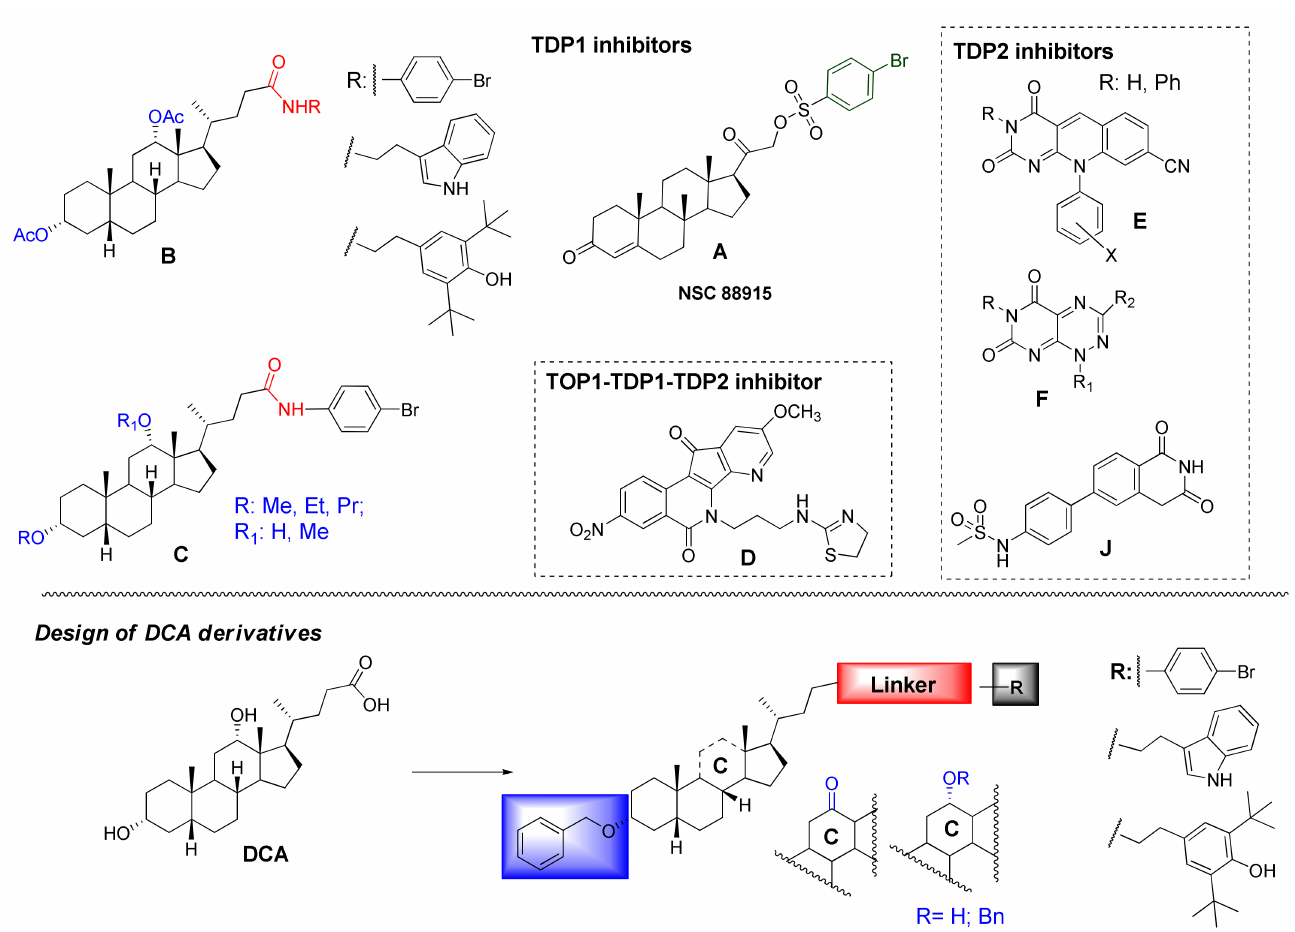
Figure 1. Structures of reported TDP1 and TDP2 inhibitors and design of DCA derivatives as inhibitors of these